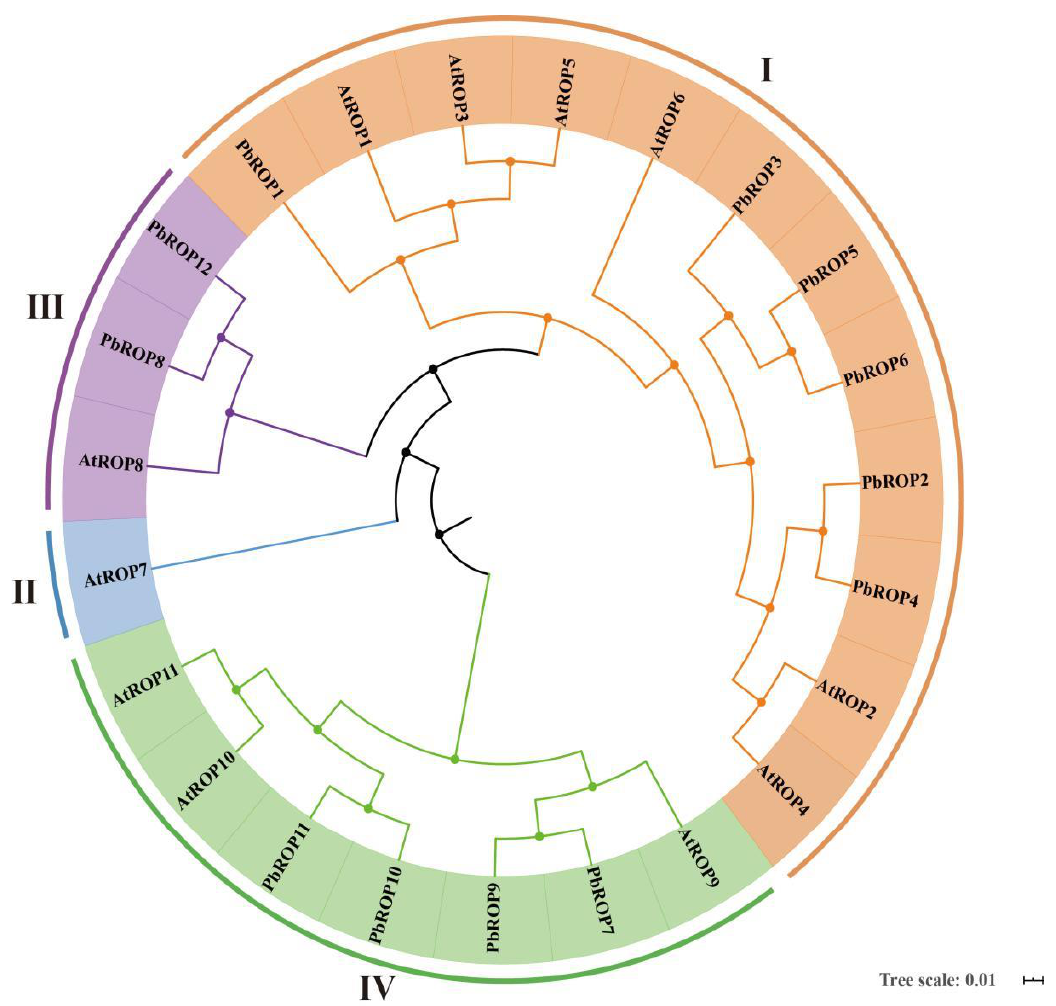
Figure 1. Phylogenetic analysis of ROPs of ‘ Duli ’ pear ( Pyrus betulifolia Bunge) and Arabidopsis. The 4 types of ROPs were marked with different colors, as indicated in the graph. The phylogenetic tree was constructed using the neighbor-joining (NJ) method for alignment and 1000 bootstrap replications.